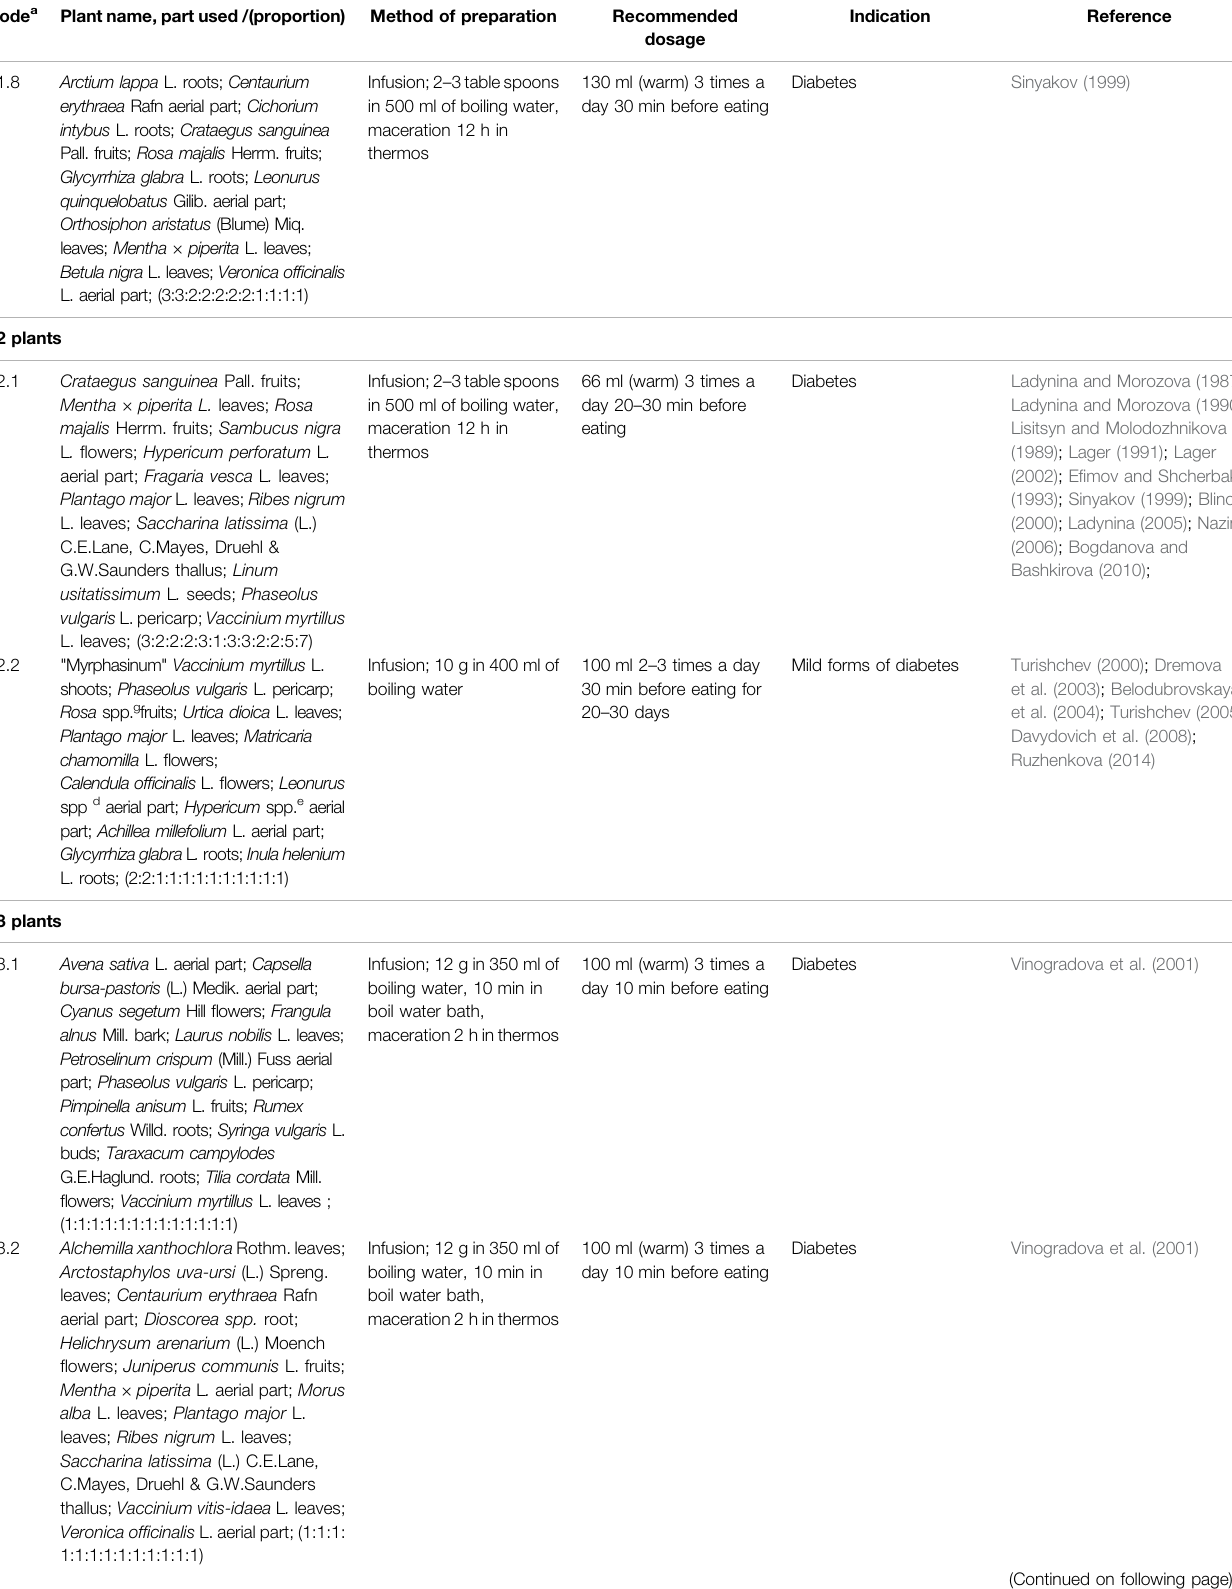
TABLE 1 | ( Continued ) The list of medical species used for the management of diabetes and related disorders in Russia. Code a Plant name, part used /(proportion) Method of preparation Recommended